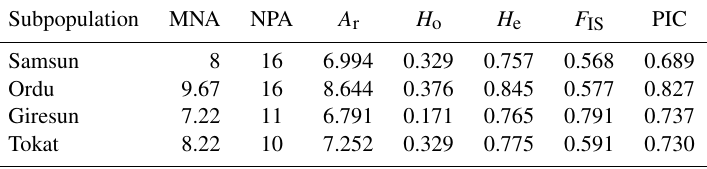
Table 3. The genetic diversity of Karayaka sheep subpopulations based on the nine microsatellite markers.